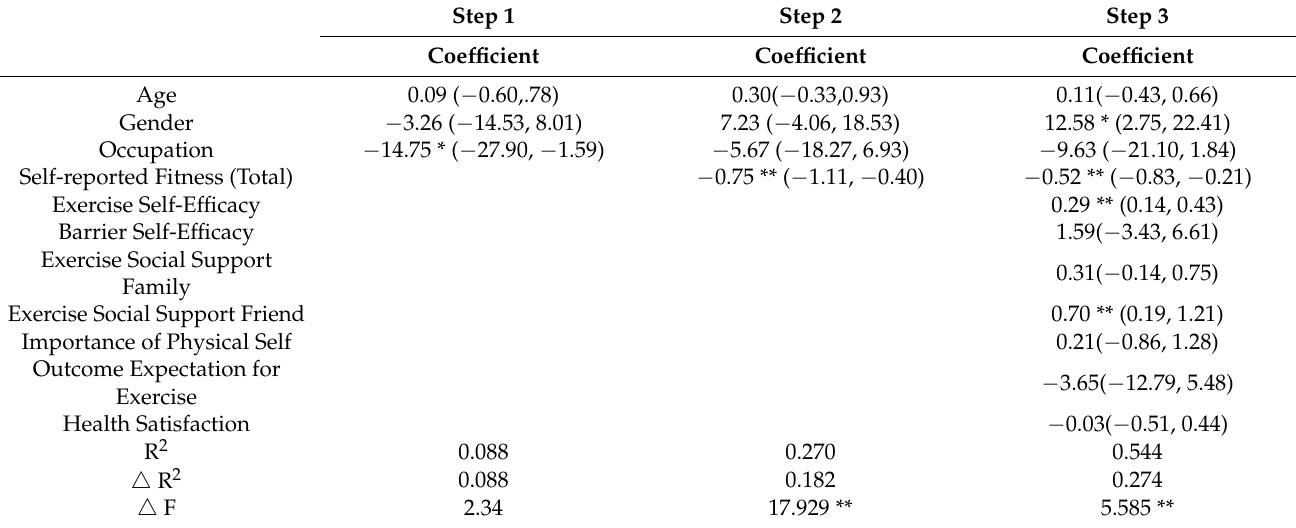
Table 3. Hierarchical multiple regression models of predicting PA from demographic variables, SCT measures, and self-reported fitness (n =